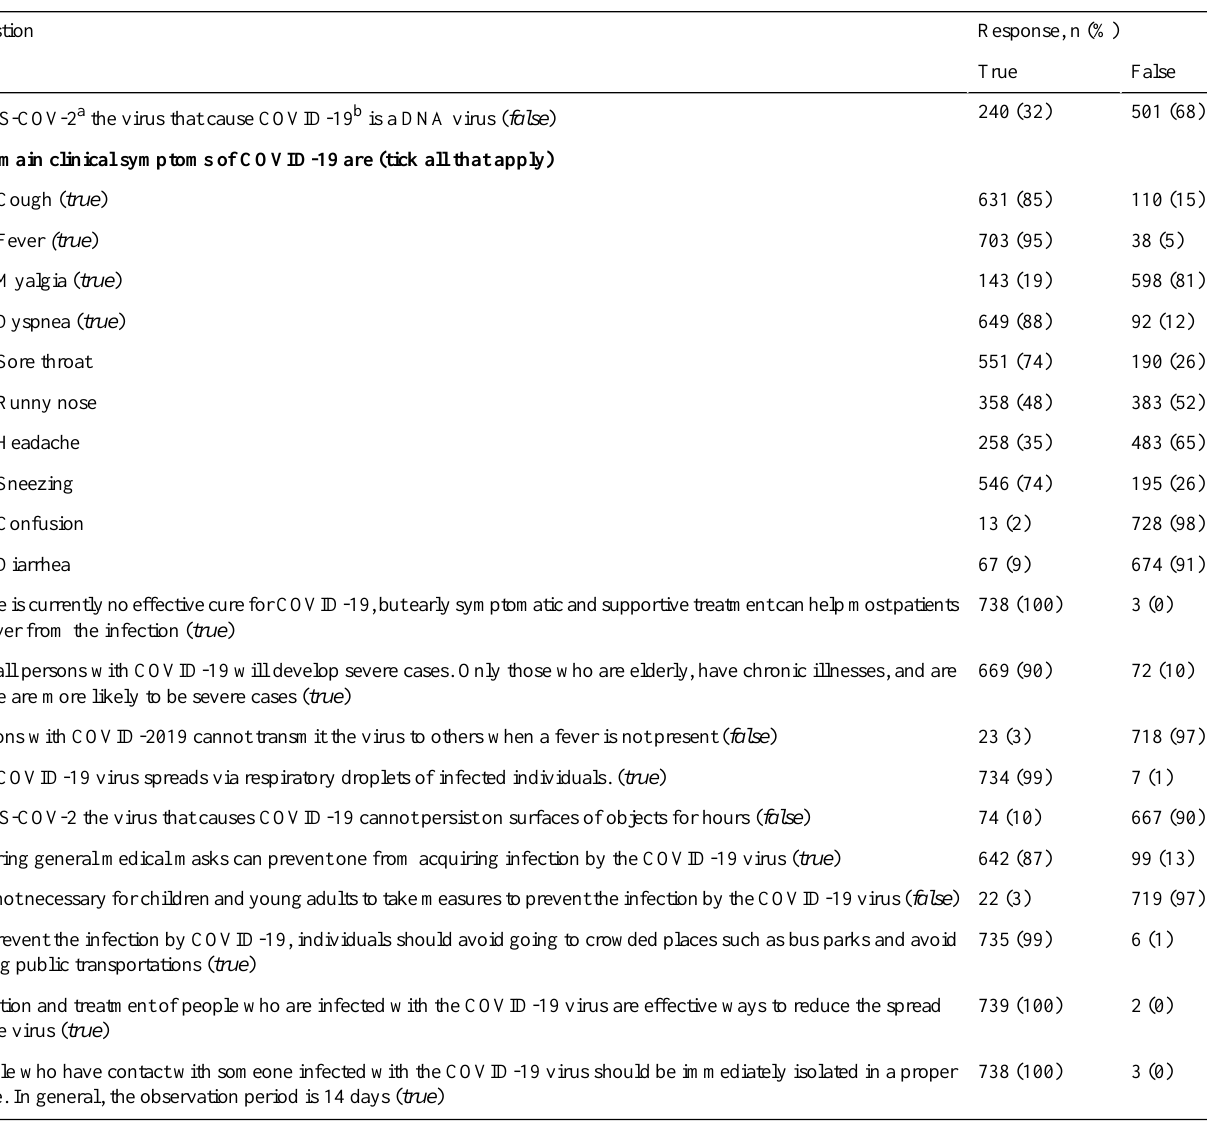
Table 2. Responses of Ugandan medical students (N=741) to questions on knowledge about